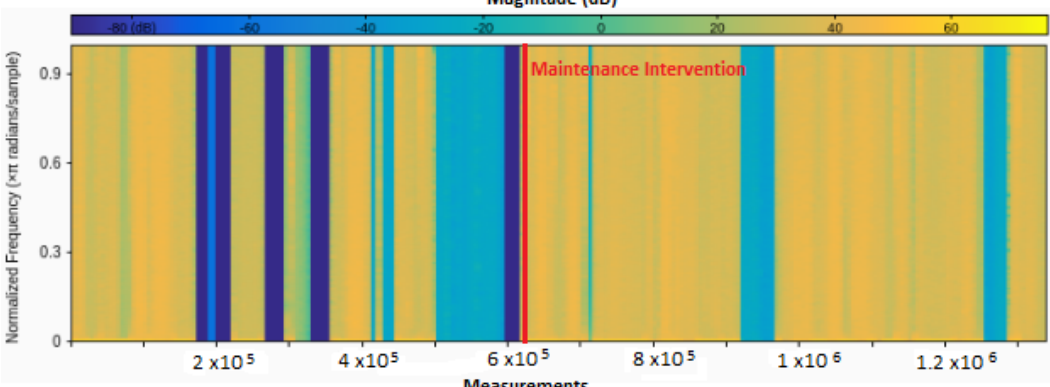
Figure 2. Degradation periods with low magnitude